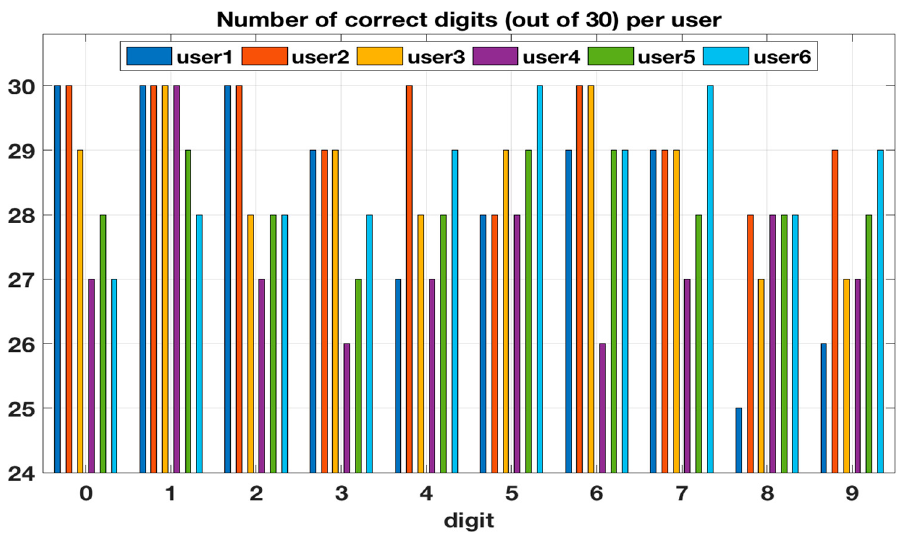
Figure 8. Number of correct digits for each user.